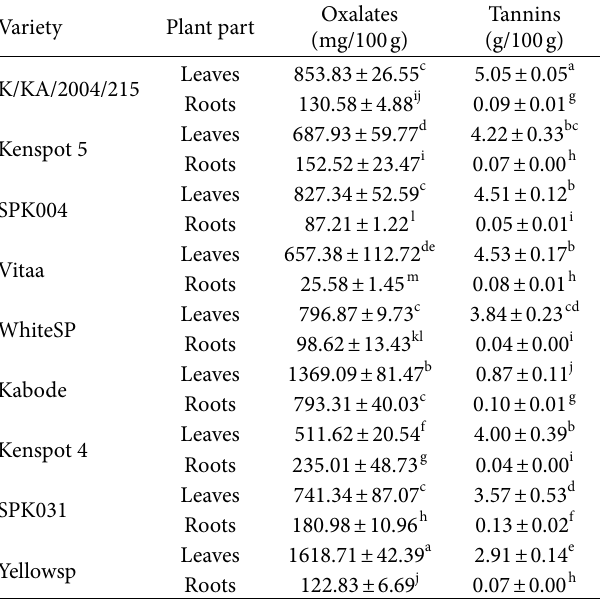
Results are means of triplicate samples ± standard deviation; values with similar letters in the same column are not significantly different at 푃 ≤ 0.05 .